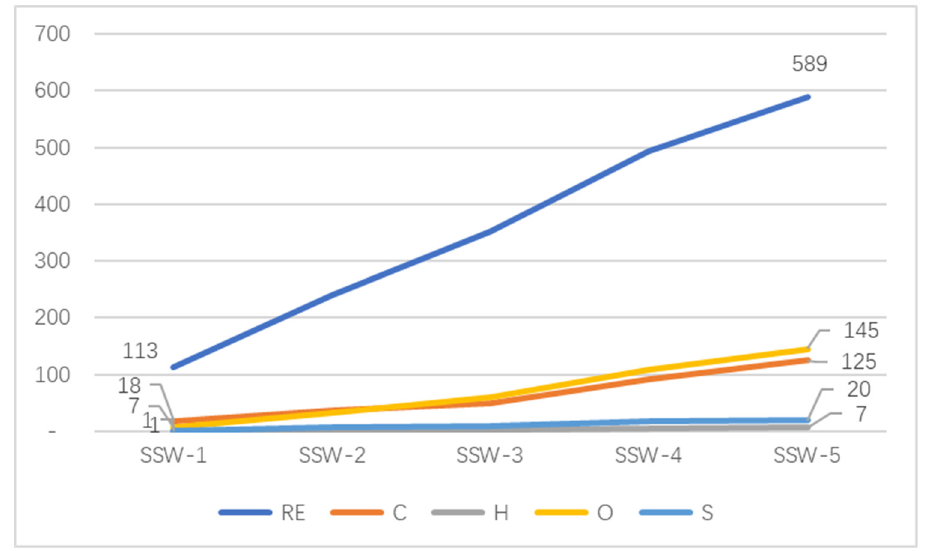
Figure 4. Spatial extent affected by urban floods. ( a ) Digital elevation model (DEM) of buildings and roads in Macau [35]; ( b ) SSW Level 1 (blue) flooding simulation results (0–0.5 m floods); ( c ) SSW Level 2 (yellow) flooding simulation results (0.5–1 m floods); ( d ) SSW Level 3 (orange) flooding simulation results (1–1.5 m floods); ( e ) SSW Level 4 (red) flooding simulation results (1.5–2.5 m floods); ( f ) SSW Level 5 (black) flooding simulation results (2.5–3.0 m floods).